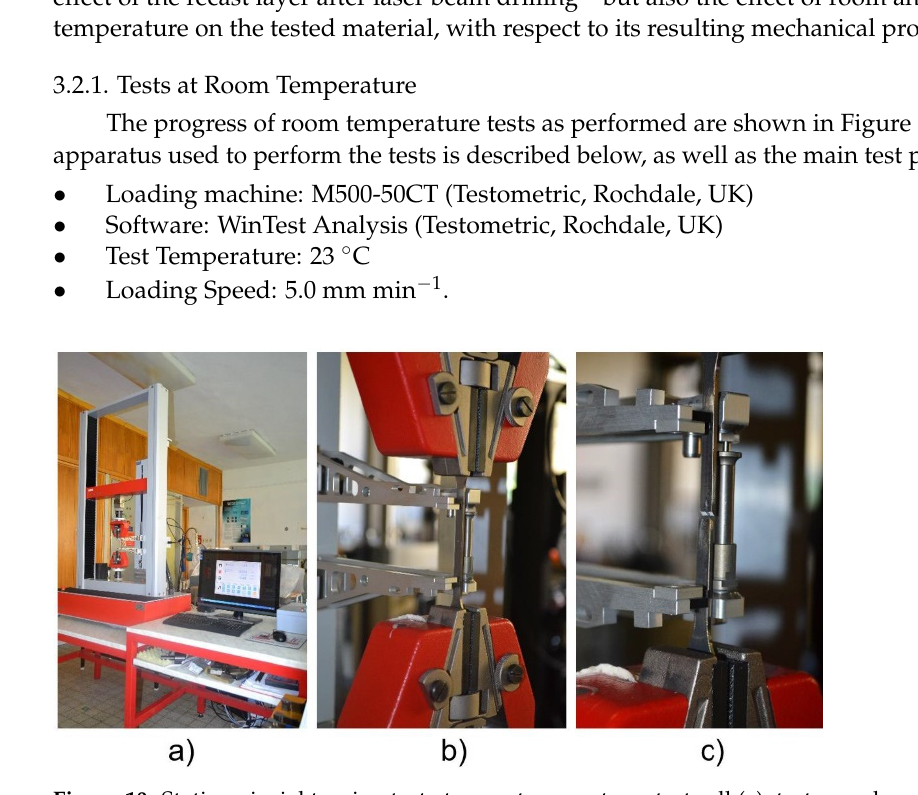
Figure 10. Static uniaxial tension test at room temperature: test cell ( a ); test sample prior ( b ); and after ( c ) the test.